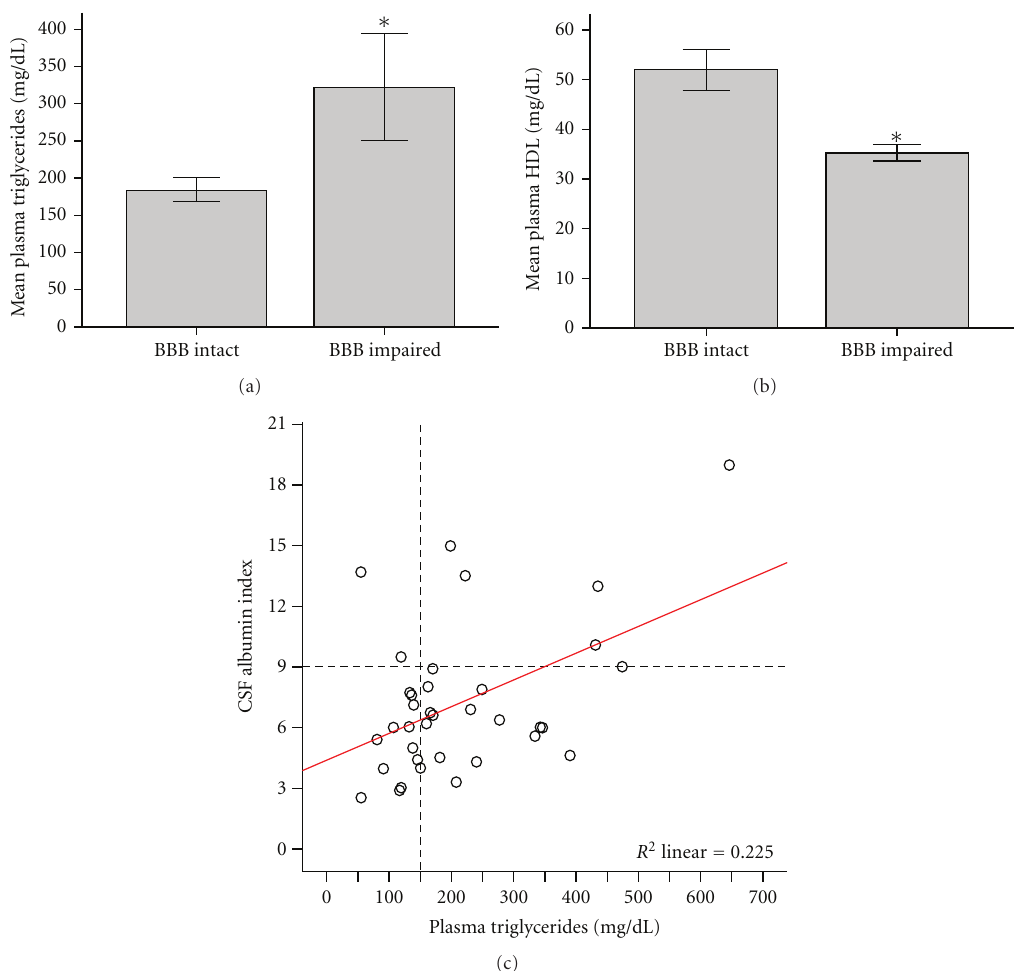
Figure 1: Relationship between plasma lipids and blood-brain barrier in subjects with AD. (a) Mean di ff erence in TG = 137.89 mg/dL, P = 0 . 007. (b) Mean di ff erence in HDL = 16.17 mg/dL, P = 0 . 043. Standard error bars around the mean set at +/ − 1.0. (c) Horizontal reference line separates the plots by subjects with (above) and without (below) BBB impairment. Vertical reference line indicates lipid risk